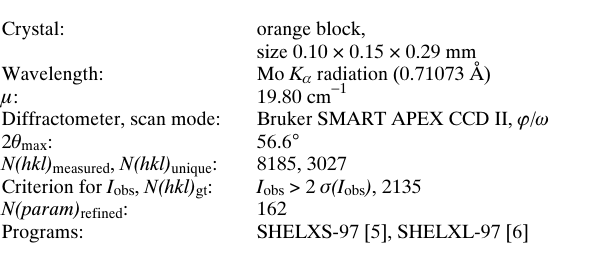
drogen bonds and intercationic (cid:3) - (cid:3) stacking interactions the structureconstituentsareinterlinkedtoa3Dnetwork(figure,bot- tom). Table 1. Data collection and